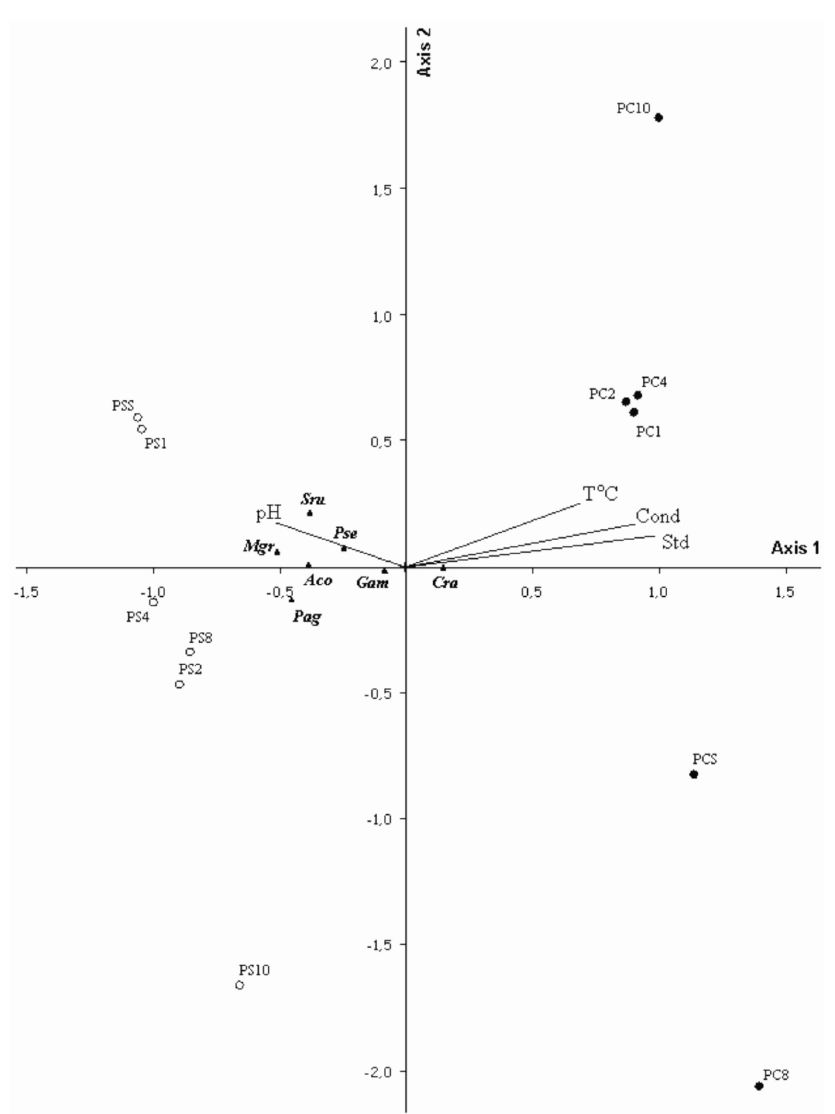
Fig. 5 – CCA scaling of the most representative environmental and biological variables in the Carpina reservoir (PE, Brazil) from January to November 2006. Abbreviations: Aco ( Anabaena constricta ); Cra ( Cylindrospermopsis raciborskii ); Pag ( Planktothrix agardhii ); Gam ( Geitler- inema amphibium ); Pse ( Pseudanabaena sp.); Sru ( Synedra rumpens ); Mgr ( Monoraphidium griffithii ); T ◦ C (water temperature), Oxy (dissolved oxygen), Cond (electrical conductivity), TDS (total dissolved solids), Tur (turbidity) and pH; DS (dry season); RS (rainy season); depths (S – surface; 1-1.0 m; 2-2.0 m; 4-4.0 m; 8-8.0 m; 10-10.0